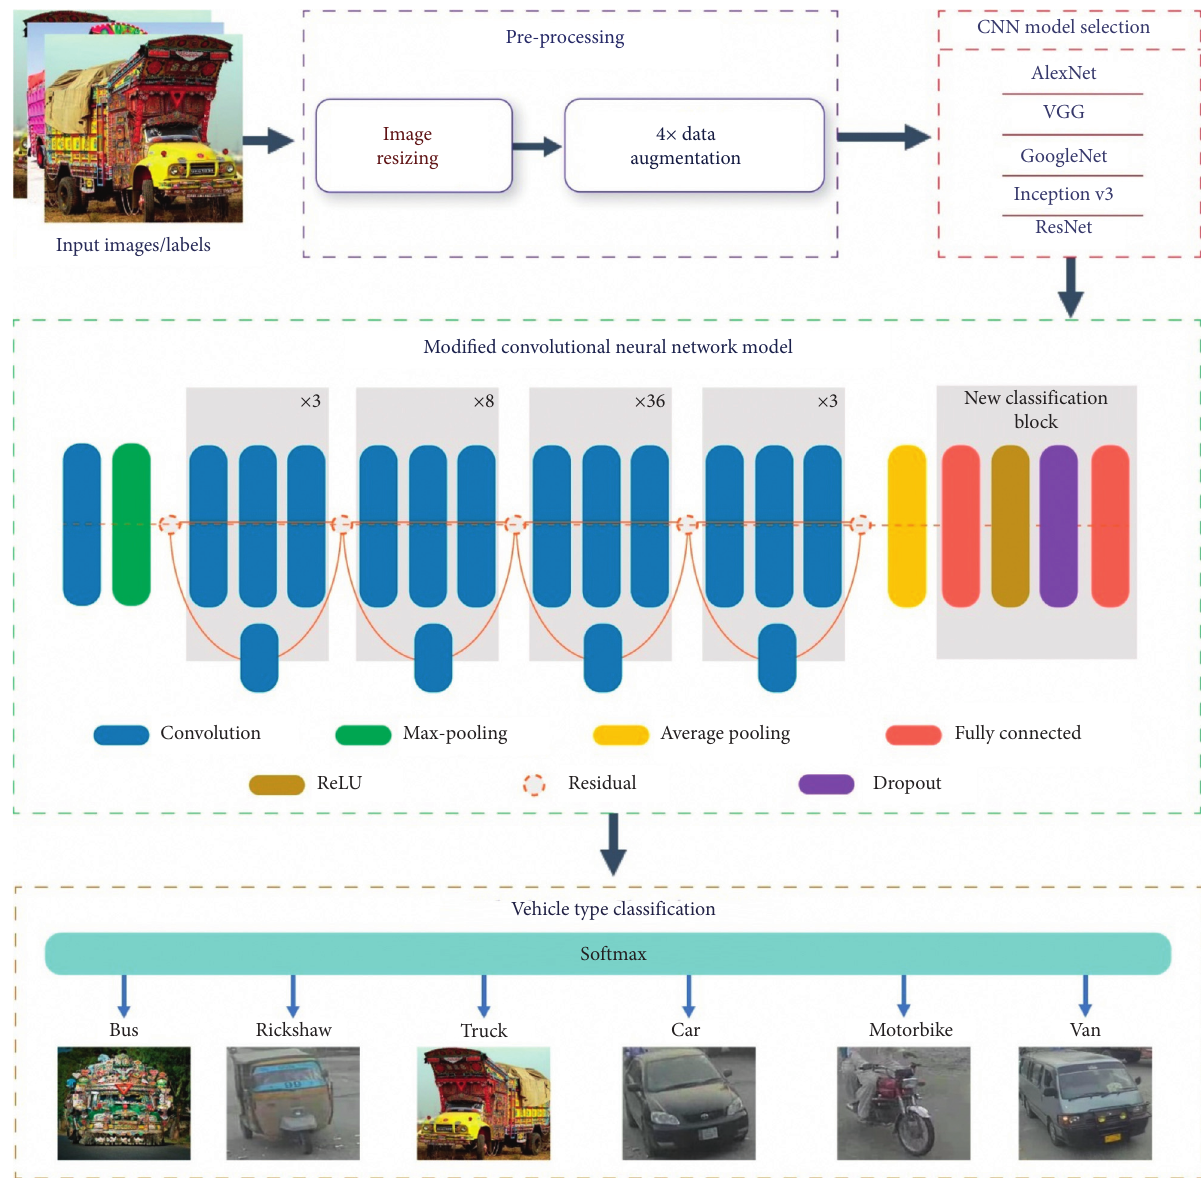
Figure 1: The proposed